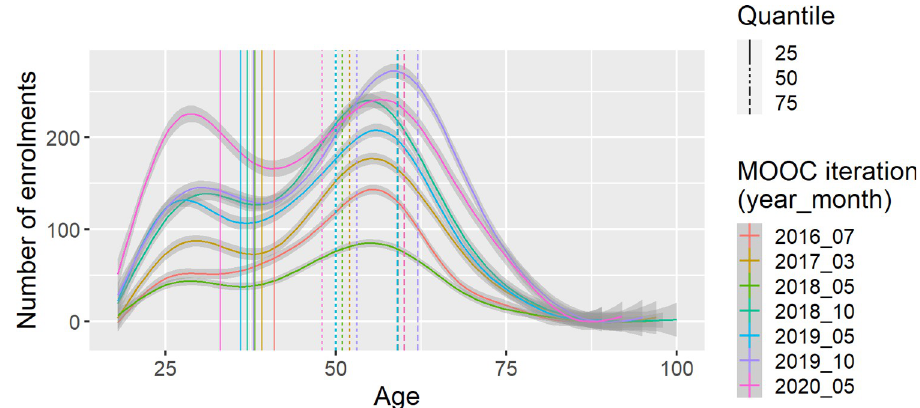
Fig 1. Number of participants with ages from 18 to 100 in each of the seven Preventing Dementia MOOC iterations (year-month). Age at which the 25 th , 50 th and 75 th quantiles occurred for each iteration is shown by the vertical lines. The age at which the 25 th quantile occurred significantly decreased over time